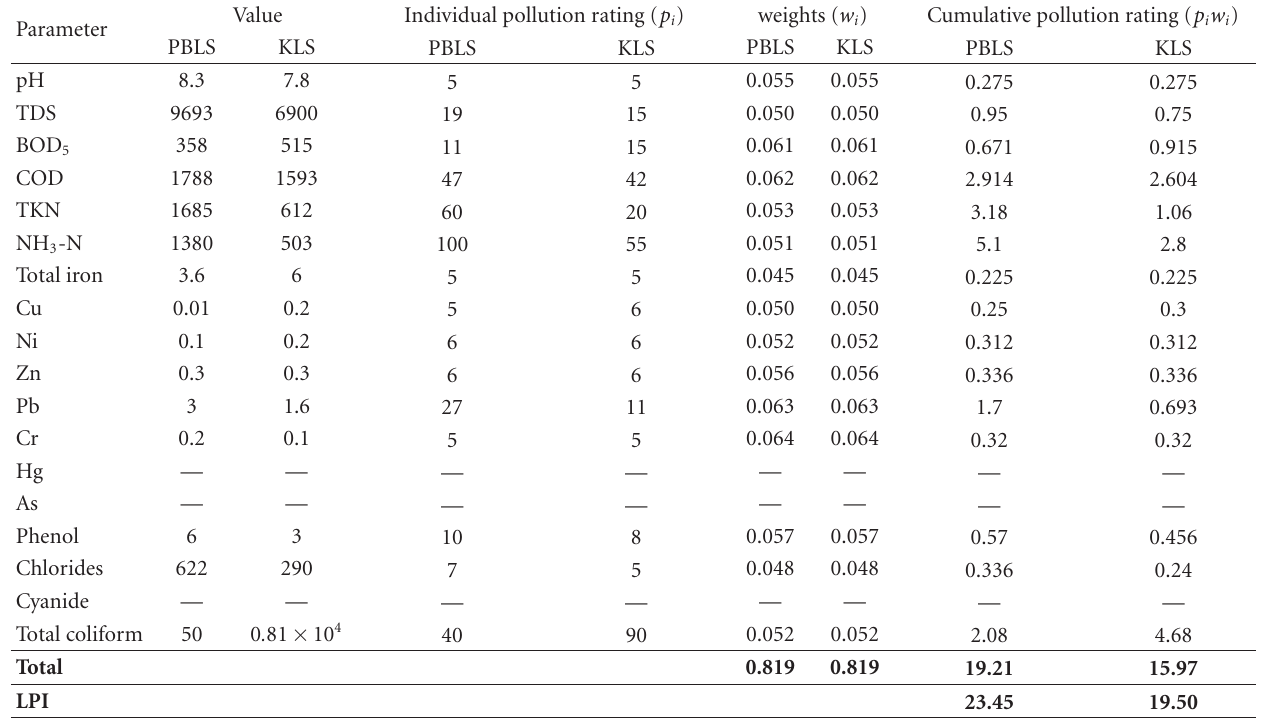
Table 1: Characteristics and LPI of leachate from PBLS and KLS ∗ .